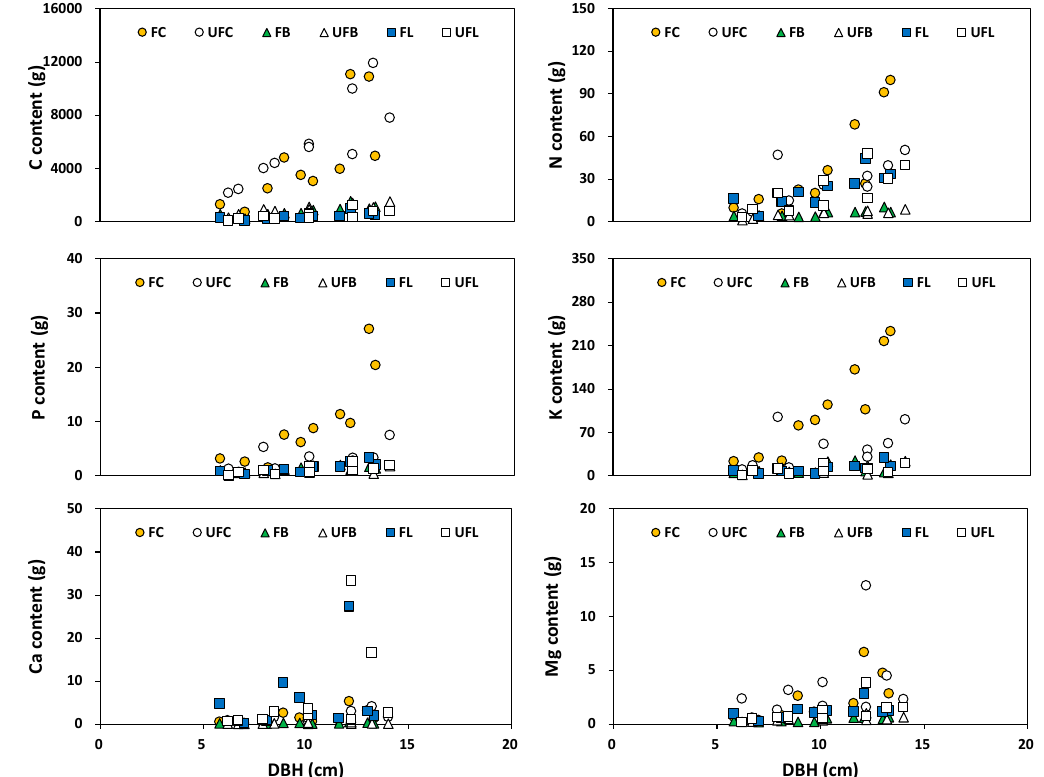
Figure 3. Relationships between nutrient content of bamboo components ( n = 20) and DBH of fertilized and unfertilized plots in Moso bamboo (FC: culms in fertilized plots; UFC: culms in unfertilized plots; FB: branches in fertilized plots; UFB: branches in unfertilized plots; FL: leaves in fertilized plots; UFL: leaves in unfertilized plots).